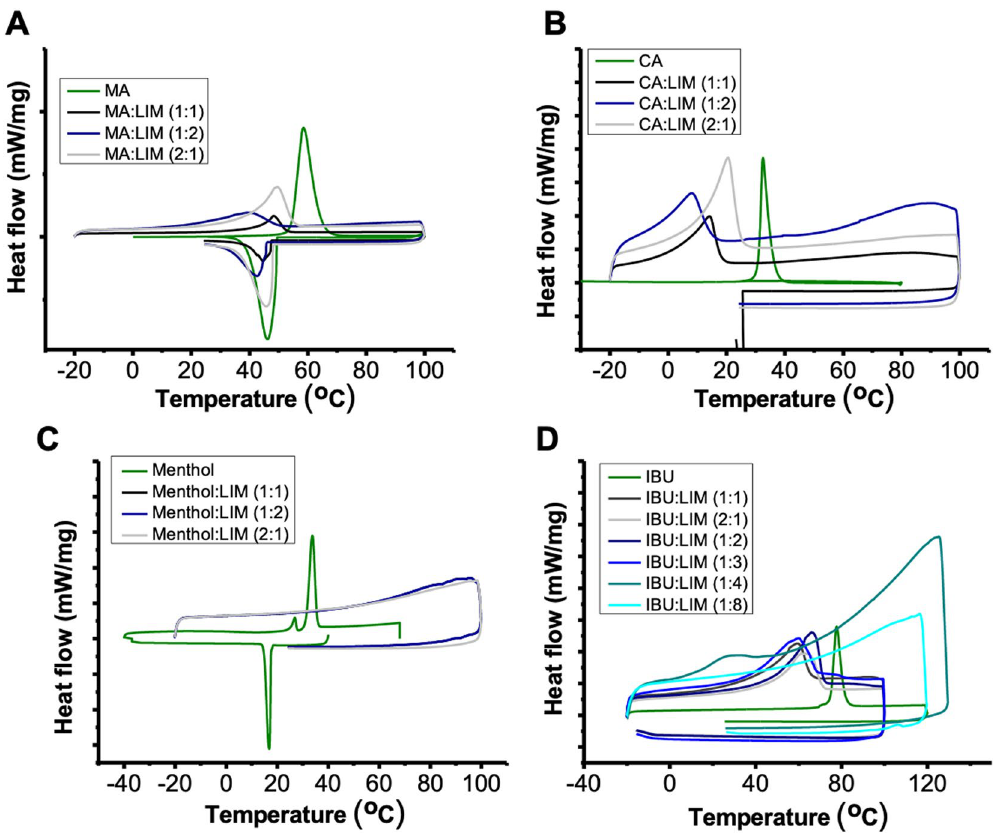
Figure 1. DSC thermograms of powders and THEDES based on LIM: ( A ) MA:LIM, ( B ) CA:LIM, ( C ) Menthol:LIM, ( D ) IBU:LIM. Peaks arising above the baseline represent endothermic peaks.